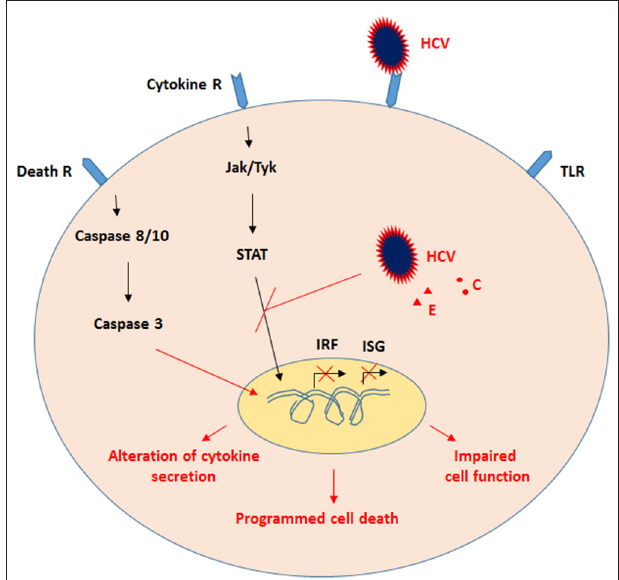
FIGURE 3 | Proposed model for the effects of HCV on PBMCs. Infection of PBMCs, which include monocytes, CD4 + T cells, CD8 + T cells, NK cells, and B cells, with HCV resulted in dysregulation of signaling-pathway mediators such as STAT-1 and IRF-1, as well as alteration in cytokine and chemokine production. Subsequently, persistent HCV RNA and its antigens, along with chronic immune activation, the PBMCs become exhausted, impaired, and more prone to